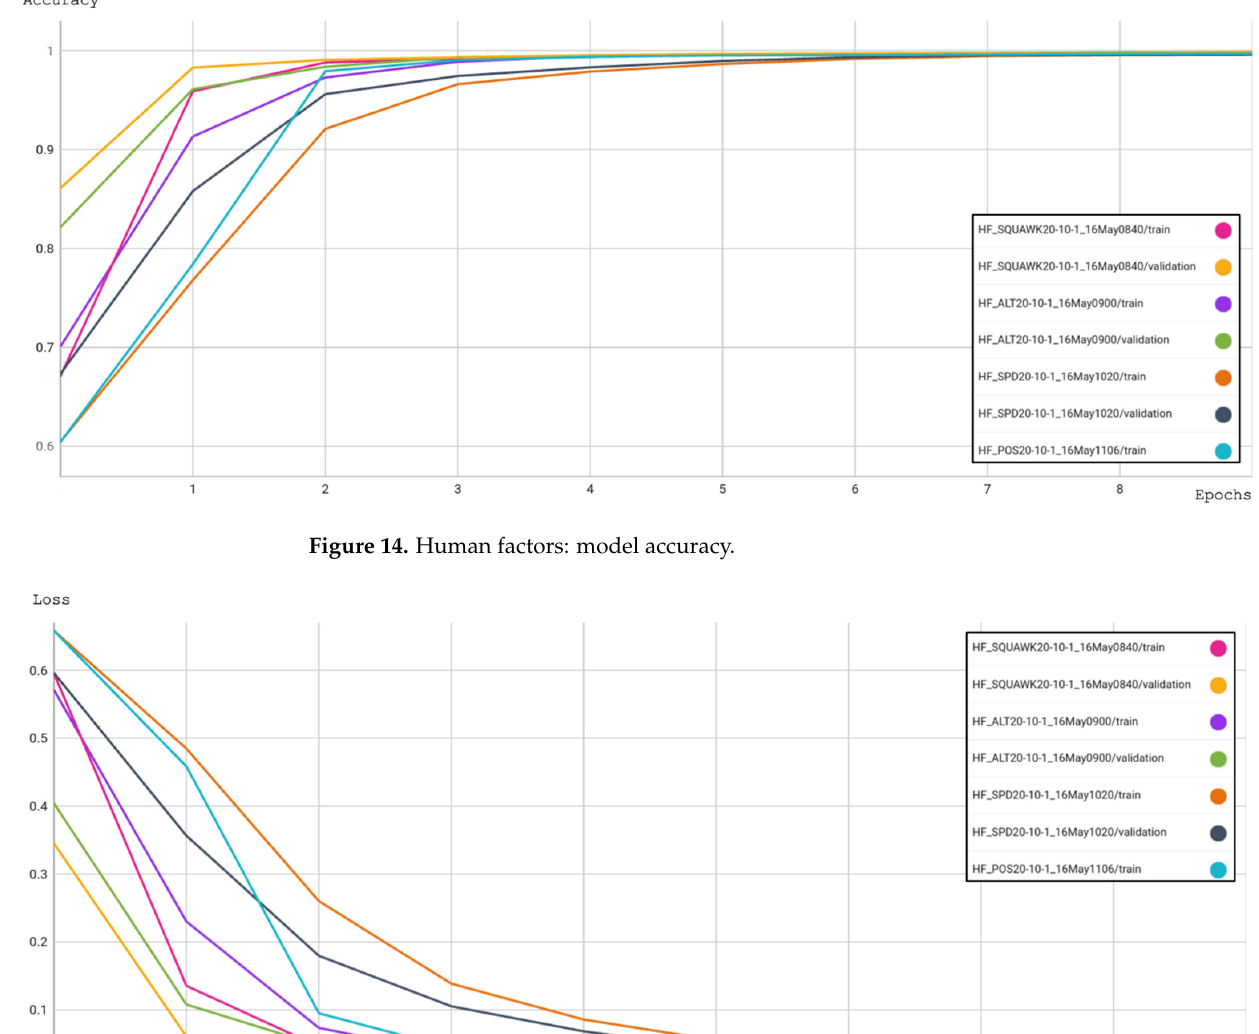
Figure 15. Human factors: model loss. One can compare the overall accuracies achieved in Figure 16. Overall, the model accuracy for all cases except weather influence management passes 99% accuracy. For the